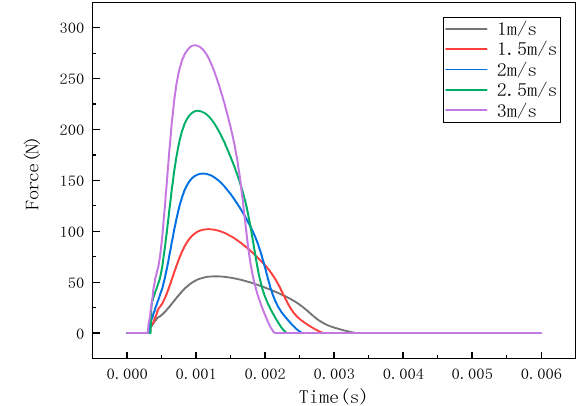
Figure 13. Impact force curve at position 3.